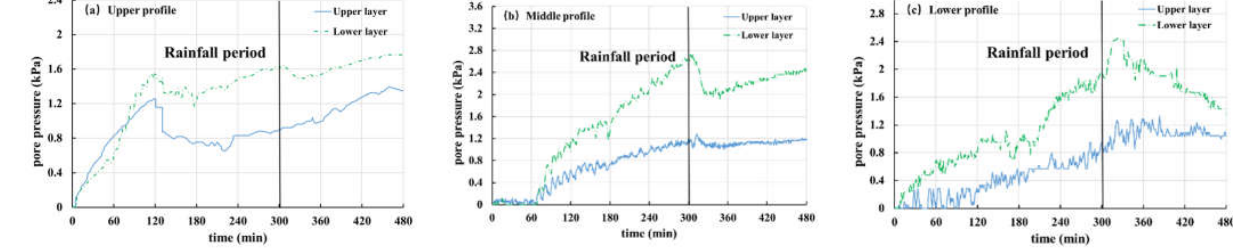
Figure 14. Curves of pore pressure in Test 5 (-, 30 mm/h): ( a ) upper profile; ( b ) middle profile; ( c ) lower profile.